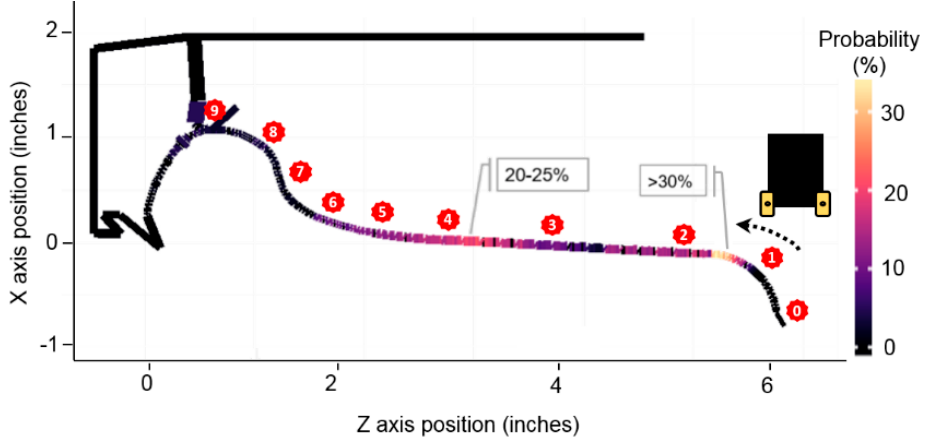
Figure 12. Resultant machining behavior extracted from data analytics for a large quantity of same type of rail wheel with the smart system activated. The red dots mark the reset points.